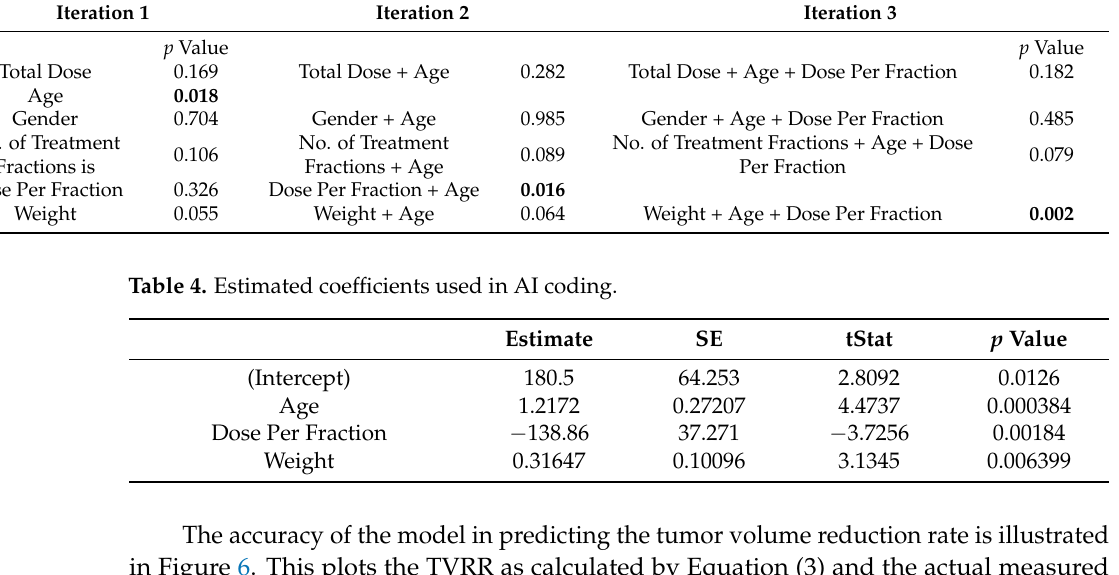
Table 3. Artificial Intelligence coding iteration.